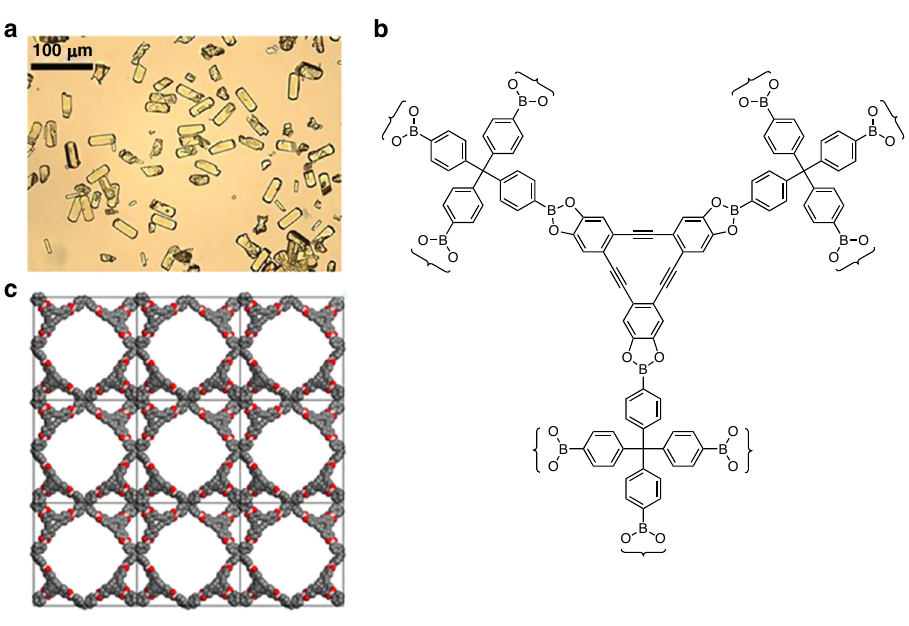
Fig. 7 Images of selected COFs. a Micrograph showing single crystals of COF-300. Adapted with permission from AAAS, ref. 54 . b Structure of DBA-3D- COF 1. c Open network of DBA-3D-COF 1, as determined by PXRD. Adapted with permission from ACS, ref. 55 .